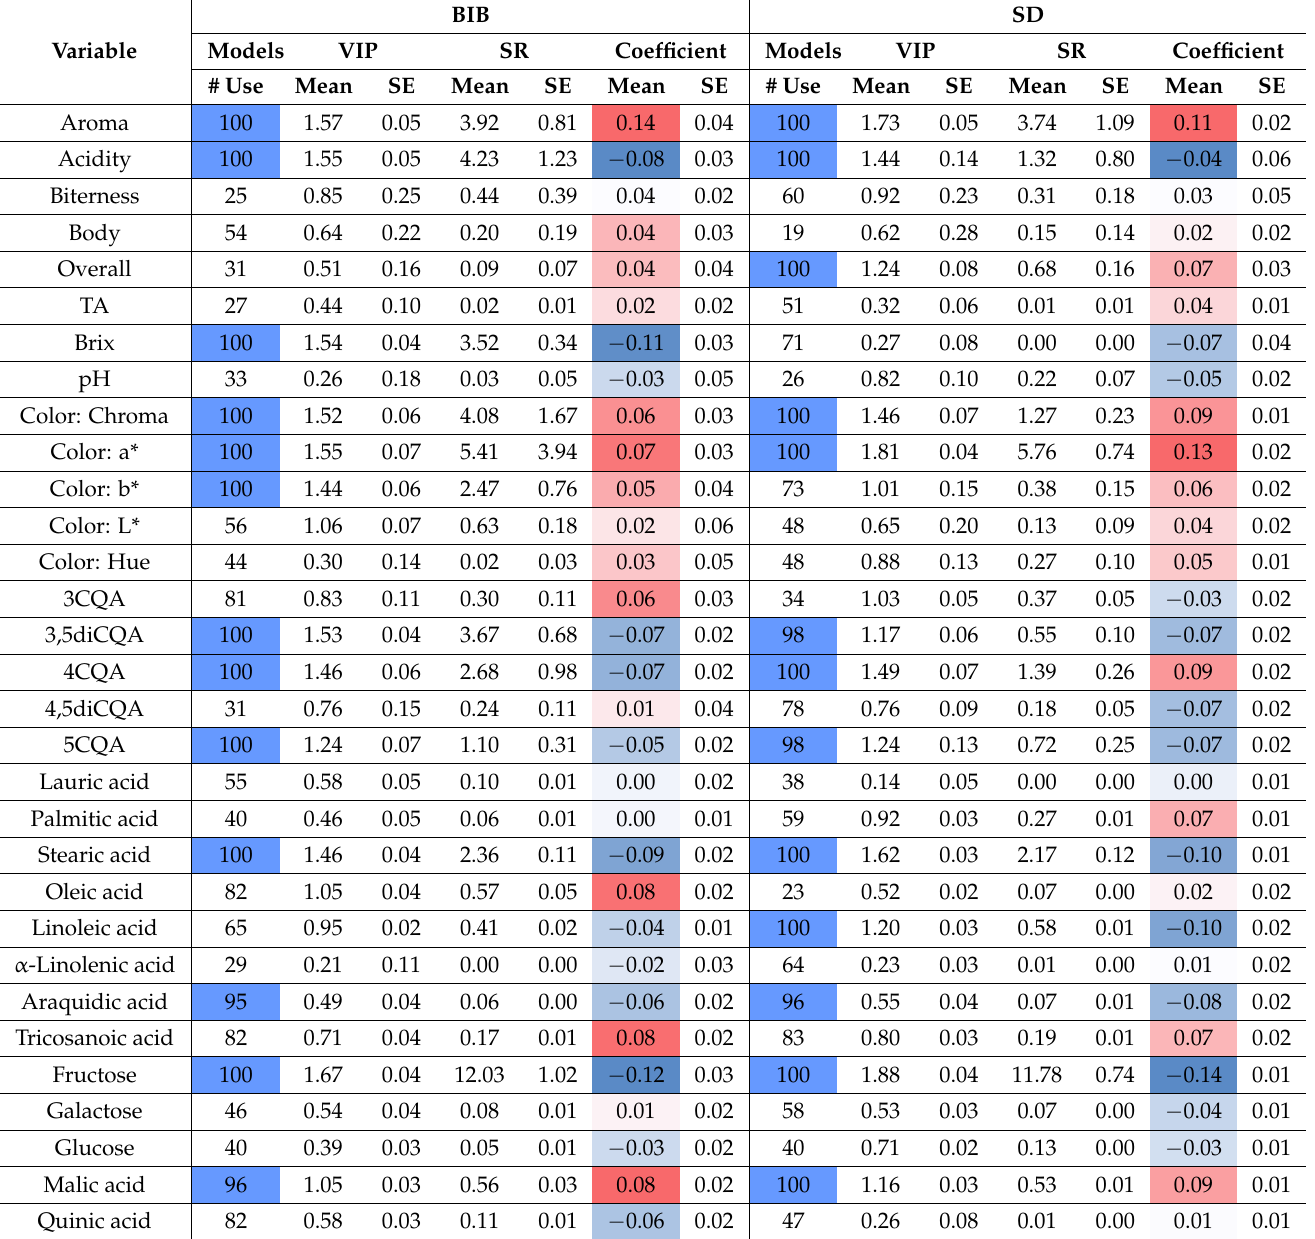
Table 2. Selection of variables included in the bootstrapped—feature selection version of the Partial Least Square (PLS) model. The column Models presents the number of times each variable was considered by the model, and the mean and standard error (SE) for VIP, selective ratio scores (SR), and the computed coefficient for BIB and